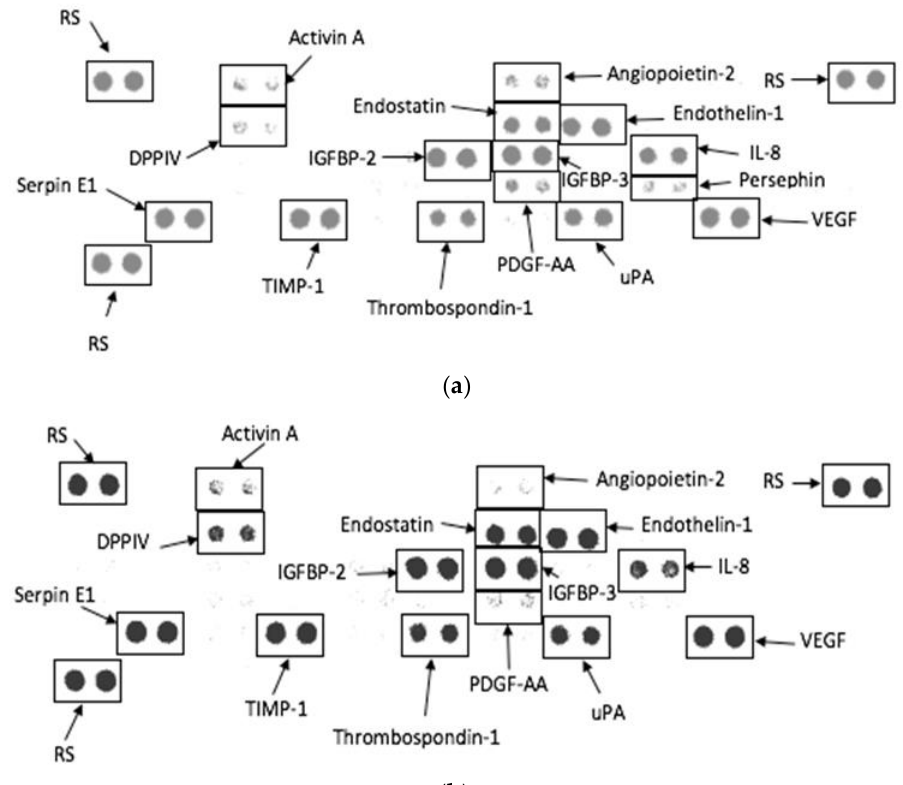
Figure 6. Angiogenesis proteome profile using culture supernatants of Caco-2 cells exposed to ( a ) control (0 µg/mL TiO2NPs) and ( b ) NOAEL concentration (100 µg/mL TiO 2 NPs) for 48 h. RS-Reference spot.